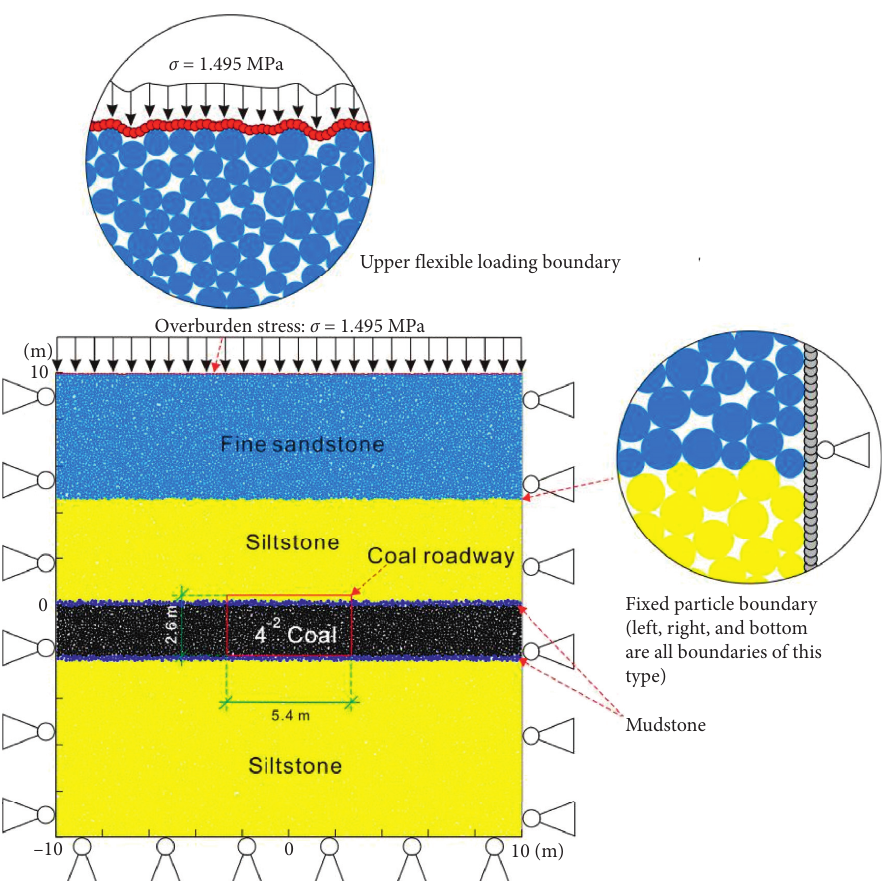
Figure 6: Cross-section of the model of rock surrounding the coal roadway, with insets showing magnified views of critical